Question: Sum up the contents of this chart in one sentence.
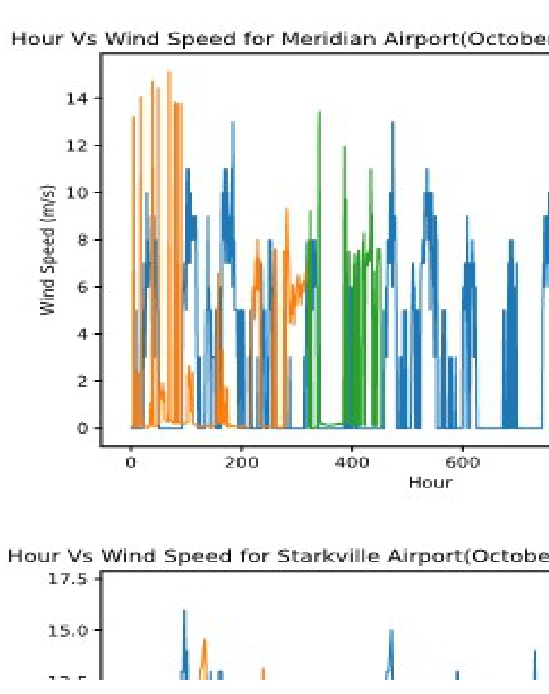
Answer: MERIDIAN VS. STARKVILLE FOR THE MONTH OF